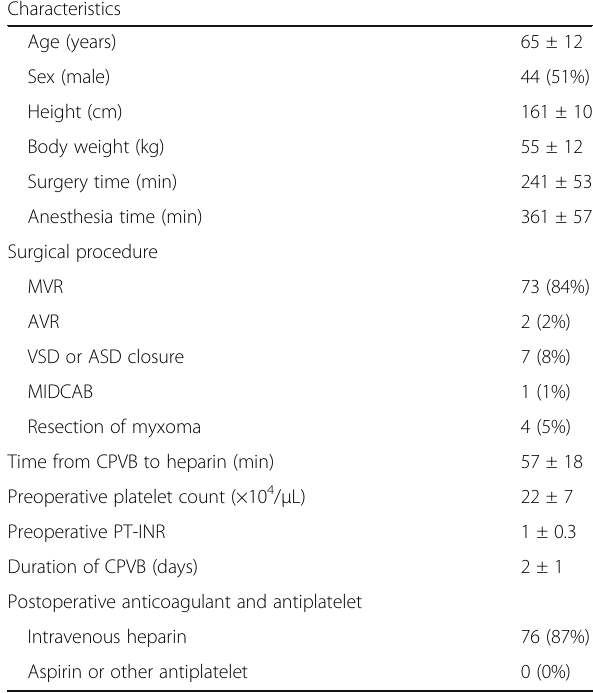
Table 1 Patient characteristics ( n = 87) Characteristics